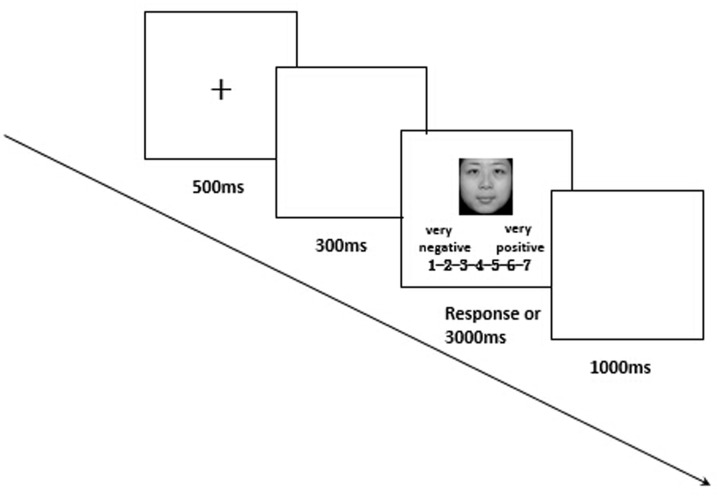
Sequence of events in the post-learning.